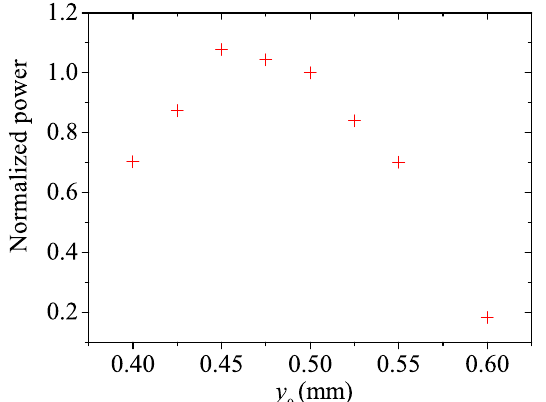
FIG. 5. Typical single-shot spectra around 3.9 nm of normal SASE FELs (dashed black), for using natural transverse gradient with (solid blue) and without (dashed dotted red) external focusing.